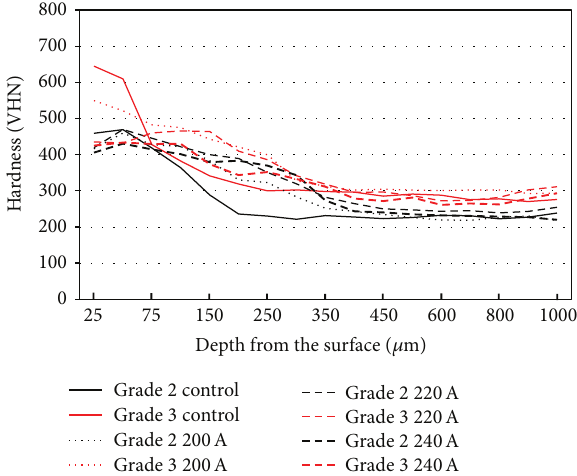
Figure 5: Tensile strengths and elongations of control specimens (grades 2 and 3) and specimens laser-treated with two different spot diameters (1.0mm and 1.6mm) at a constant emission current of 240 A and a pulse duration (10ms).